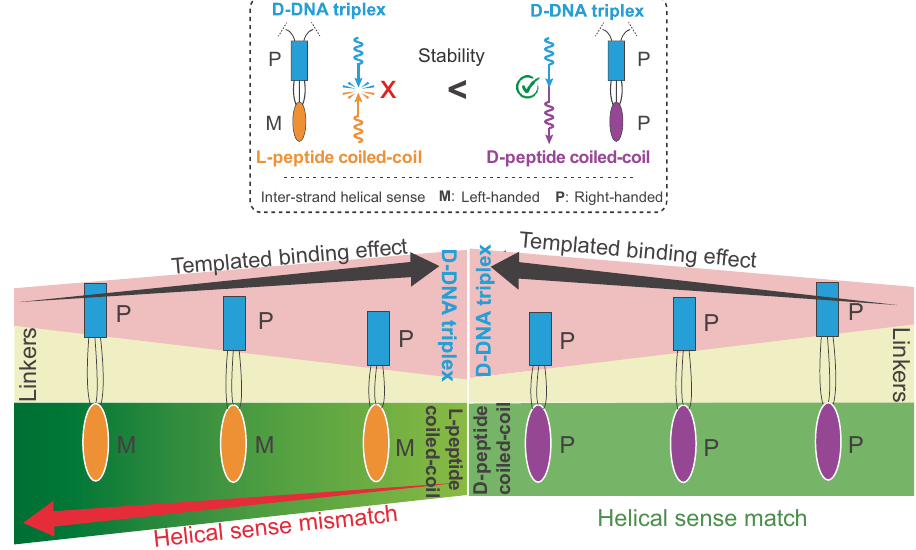
Fig. 6 The stability of POC triple helices is in fl uenced by the helical sense mismatch/match and the templated binding effect. D-DNA triplex is marked in cyan rectangle, L-peptide coiled-coil in orange ellipse and D-peptide coiled-coil in purple ellipse. M and P stand for left-handed and right-handed inter- strand helical senses, respectively. (Top: The clash symbol means the helical sense mismatch state, which may result in unfavourable energy cost and thus is marked in a red-cross. The no clash symbol represents the helical sense match state, which should not in fl uence the stability and thus is marked in a green